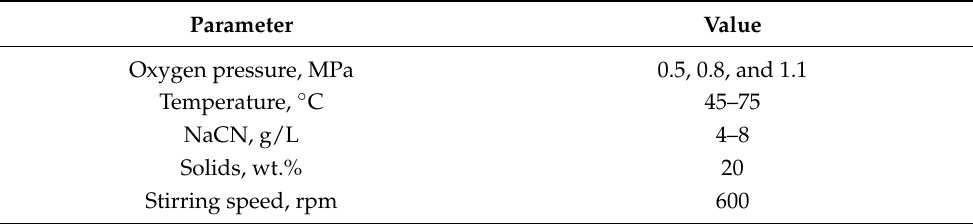
Table 1. Process variables and parameters for simultaneous pressure leaching and oxidation.